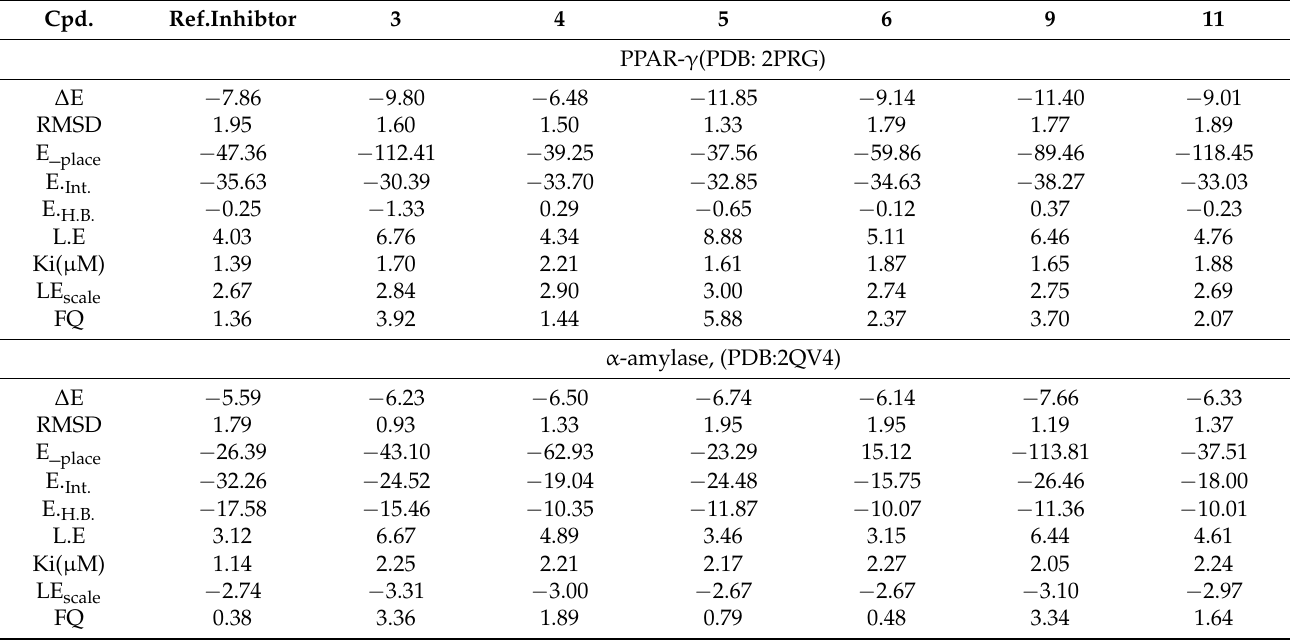
Table 2. Docking energy scores (kcal/mol) derived from the MOE for ( 3 – 6 , 9 , and 11